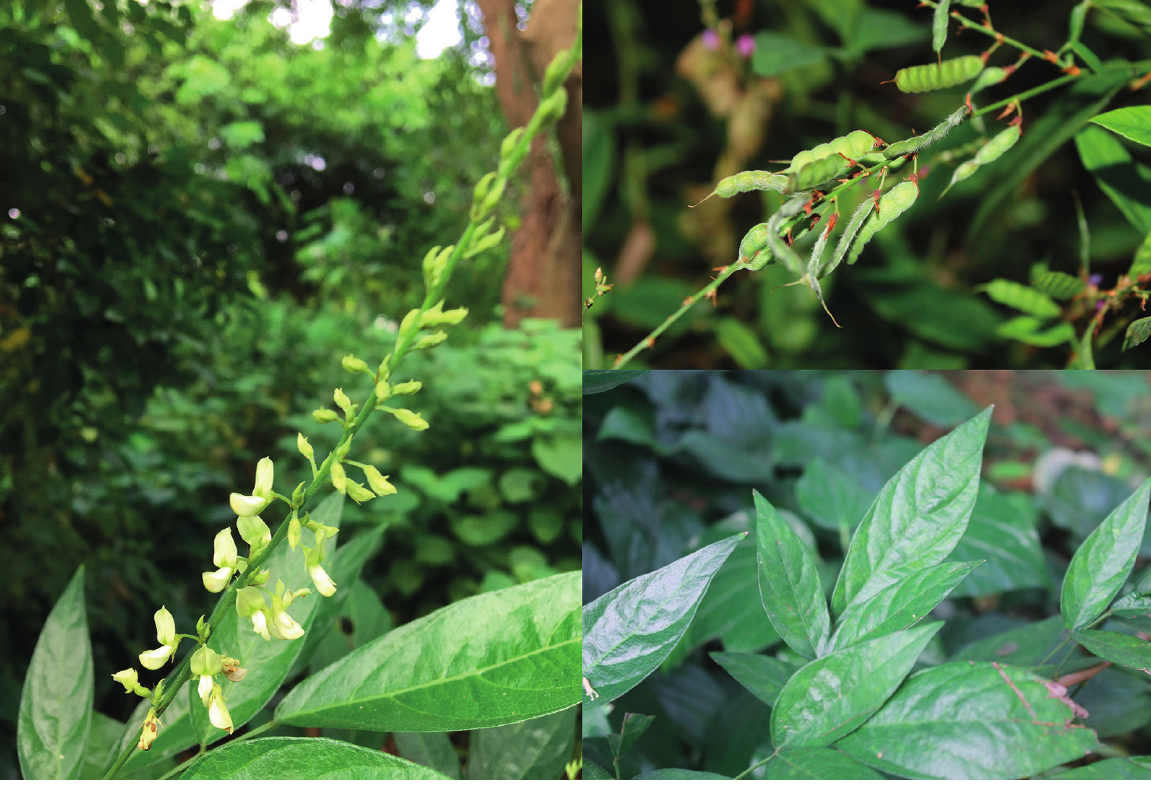
Figure 1 - The plant of Desmodium